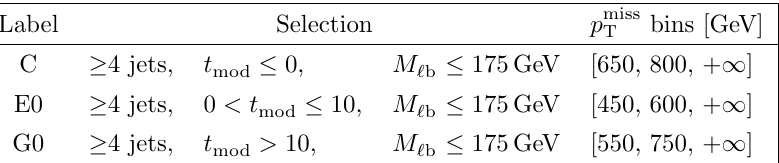
Table 5 . Search regions where the corresponding 0b control samples are combined when estimating the W + jets